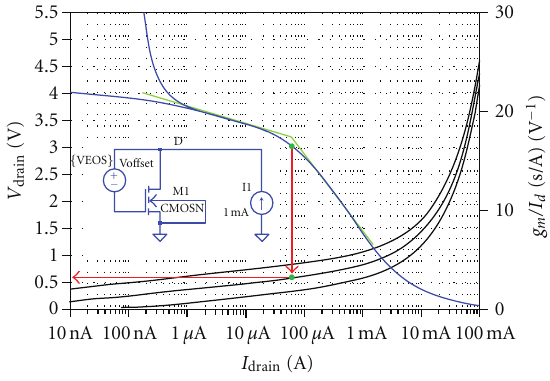
Figure 6: Transconductance figure of merit extracted from sim- ulation of a diode-connected FET. The e ff ect of length on the transition from weak to strong inversion is clearly seen. Longer transistor channel lengths have larger output resistance because they are less a ff ected by channel length modulation, but have lower drive currents in moderate inversion.